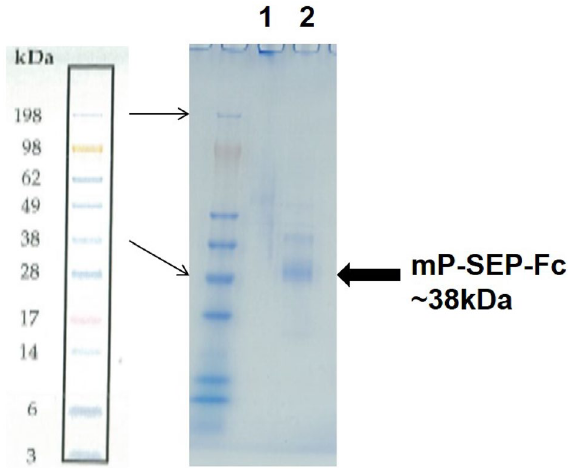
Figure 6. SDS-PAGE of a purified recombinant mouse sCD14-ST-Fc antigen. Purified mouse sCD14-ST-Fc was applied to SDS-PAGE without (1) or with (2) reducing agent and detected by CBB solution. The molecular weight of mouse sCD14-ST-Fc in reduced condition was about 38 kDa (Mouse presepsin; 13 kDa + Human Fc; 25 kDa in reduced